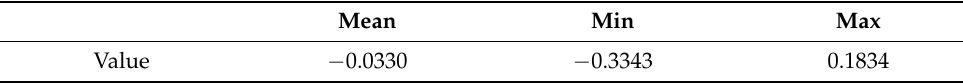
Figure 5. Dynamic correlation between Bitcoin attention and carbon futures returns. The X-axis refers to the time while the Y-axis represents the values for the reported time series. Table 14. Descriptive statistics of the dynamic correlation.